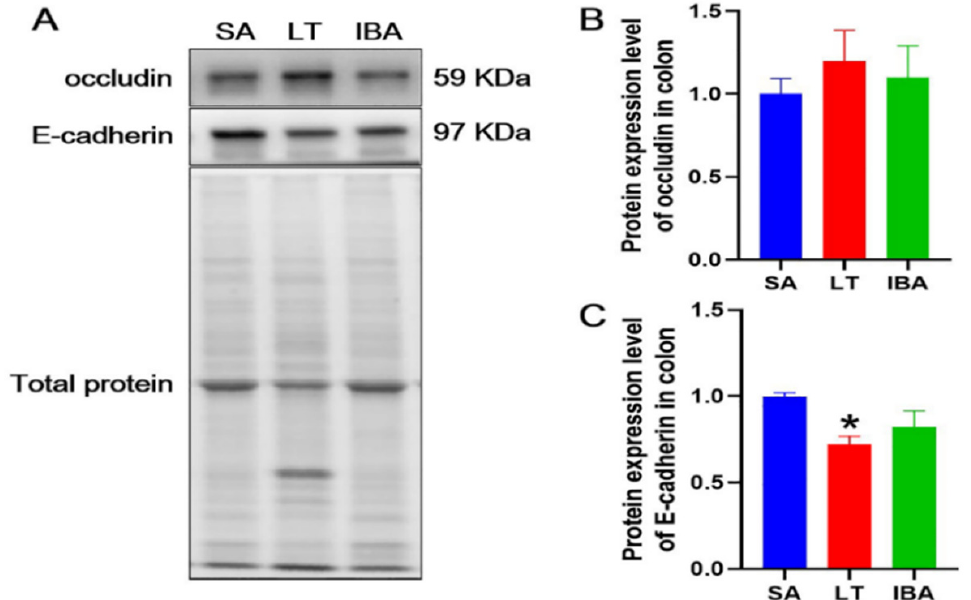
Figure 8. ( A ) Representative immunoblot images of occludin and E-cadherin in the colon of Daurian ground squirrels. ( B ) Statistical graph of protein expression level of occludin. ( C ) Statistical graph of protein expression level of E-cadherin. SA, summer active; LT, late torpor; IBA, interbout arousal. Mean ± SEM. n = 3. * p < 0.05, compared with SA group.